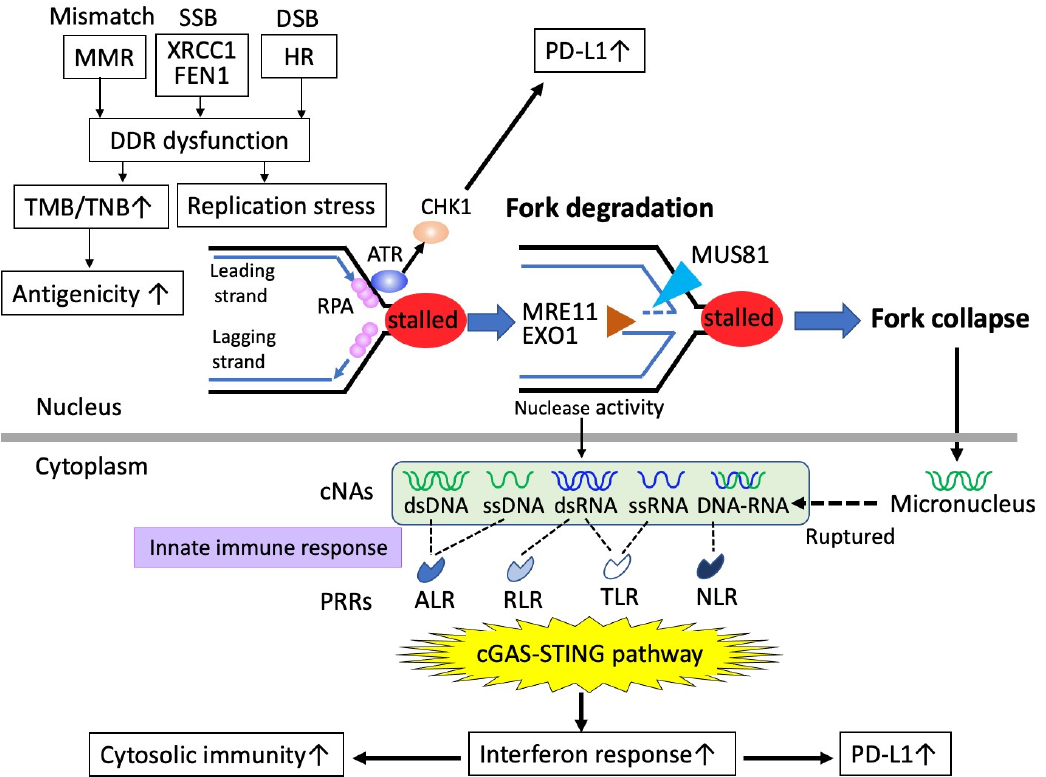
Figure 3. Dysfunction of DDR or PARPis induce the cGAS-STING pathway to activate cytosolic immunity. While some DDR dysfunction leads to increased tumor mutation burden (TMB) or tumor neoantigen burden (TNB), which enhances tumor antigenicity, other DDR dysfunction, such as via PARPis, causes stalled replication forks, triggering ATR/CHK1 activation leading to upregulated PD-L1, and replication stress responses inducing fork degradation via several nucleases, including MRE11, EXO1, and MUS81, result in the generation of cytosolic nuclear acids (cNAs). Fork collapse by the above nucleases induces genetic instability and generates micronuclei, which rupture and become cNAs. These cNAs are recognized by pattern recognition receptors (PRRs) as part of the innate immune response, triggering cGAS-STING signaling to increase cytosolic immunity. These acronyms are defined as follows: ALR, AIM2-like receptors; ATR, ataxia-telangiectasia-mutated protein kinase; cGAS, cyclic GMP-AMP synthase; CHK1, checkpoint kinase 1; DDR, DNA damage response; DSB, double strand break; FEN1, flap endonuclease 1; HR, homologous recombination; MMR, mismatch repair deficiency; PD-L1, programmed cell death ligand-1; RLR, RIG1-like receptors; RPA, replication protein A; SSB, single strand break; TLR, Toll-like receptors; NLR, NOD-like receptors; STING, stimulator of interferon genes; XRCC1, X-ray repair cross-complementing 1.